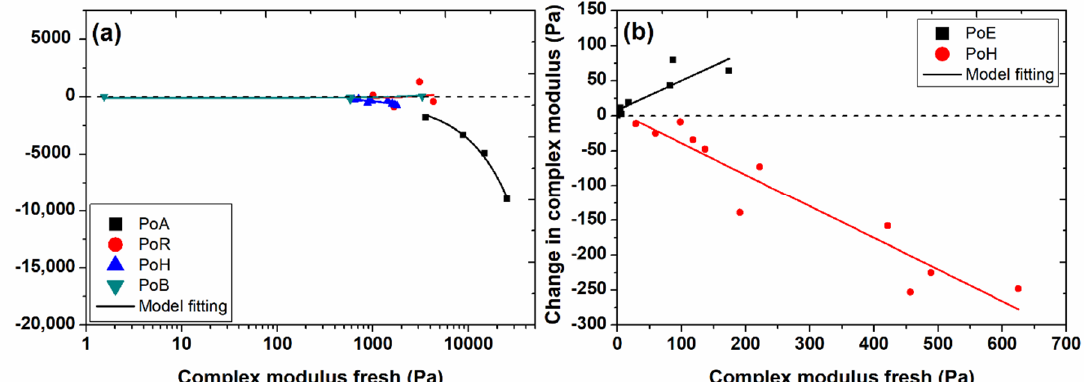
Figure 6. Change in complex modulus (degraded–fresh) at 1 Hz as a function of complex modulus at 1 Hz of fresh mud samples ( a ) from different ports and ( b ) from PoE and fluid mud samples from PoH. The solid line represents the empirical fitting using Equation (1). The dashed line represents the value where the degraded and fresh mud samples have the same complex modulus at 1 Hz.